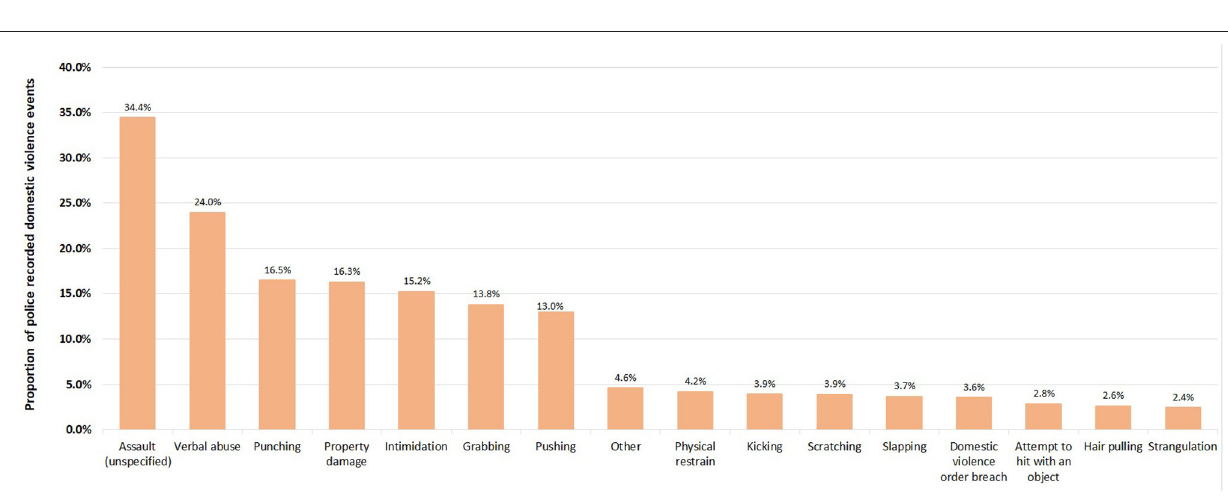
illness recorded in POIs with increasing rates across the 12- ( Table 1 ). Interestingly, alcohol abuse in male POIs had the highest proportion of domestic violence events between 2005 and 2008 (25.2–26.4%) but decreased over time (12.4% in 2016) ( Table 1 ). Similarly, alcohol abuse was observed to decline over time for female POIs from 19.2% in 2005 and to 11.6% in